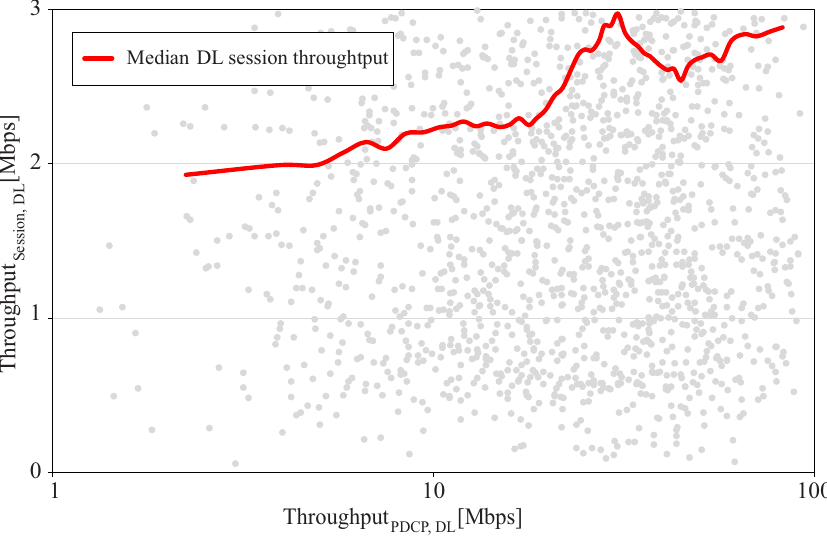
Figure 3. QoS and traffic indicators for streaming services.